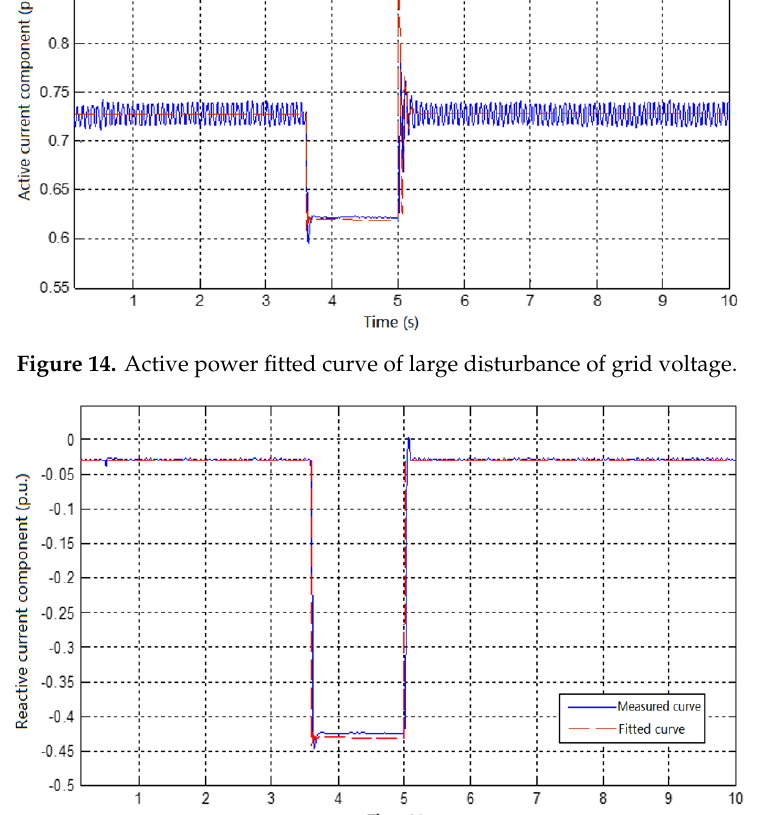
Figure 15. Reactive power curve of large disturbance of grid voltage. Table 4. Model evaluation of active current under large disturbance of grid voltage.